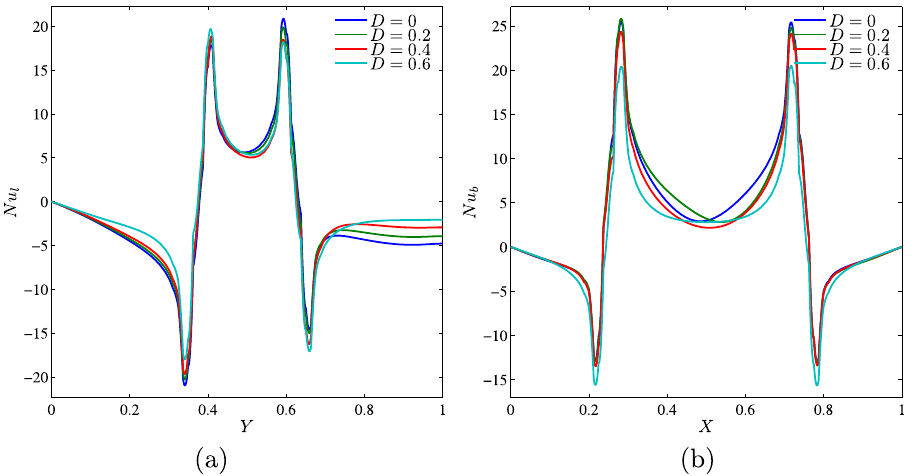
Figure 20. Variation of local Nusselt number interfaces with ( a ) Y and ( b ) X for different D at Ra = 10 5 , = φ = 0.02, Ha = 15 and k w